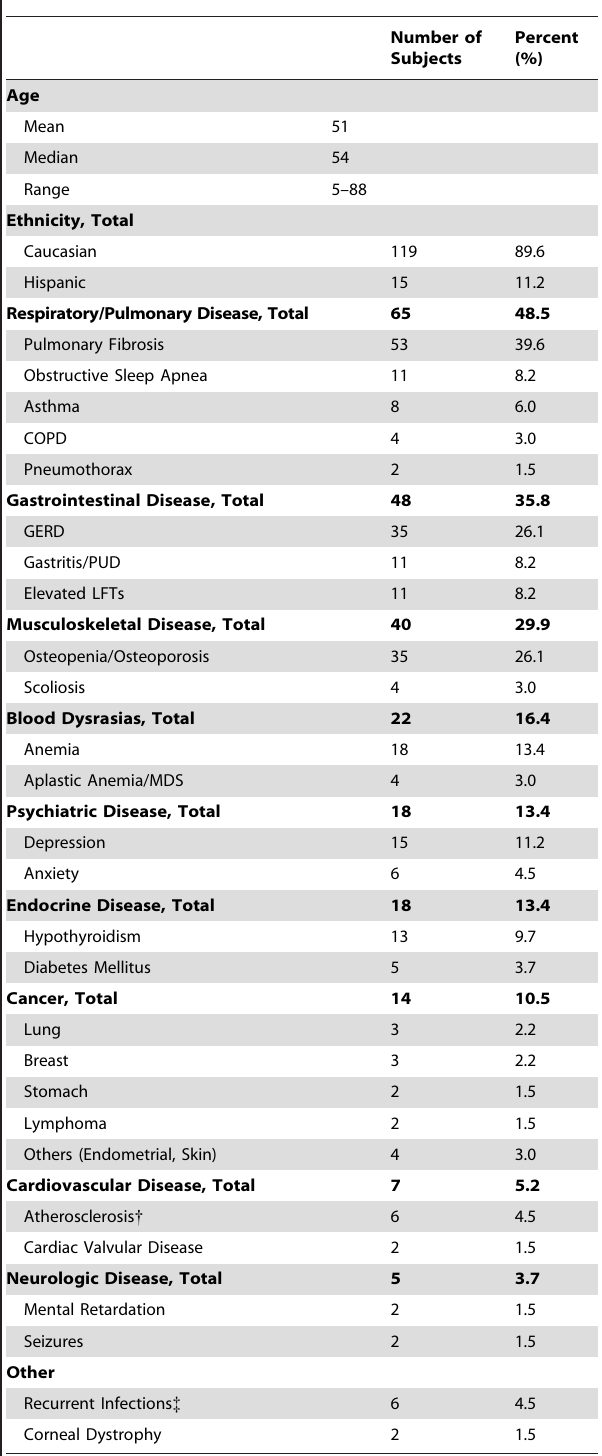
Table 1. Phenotype of 134 subjects with heterozygous TERT